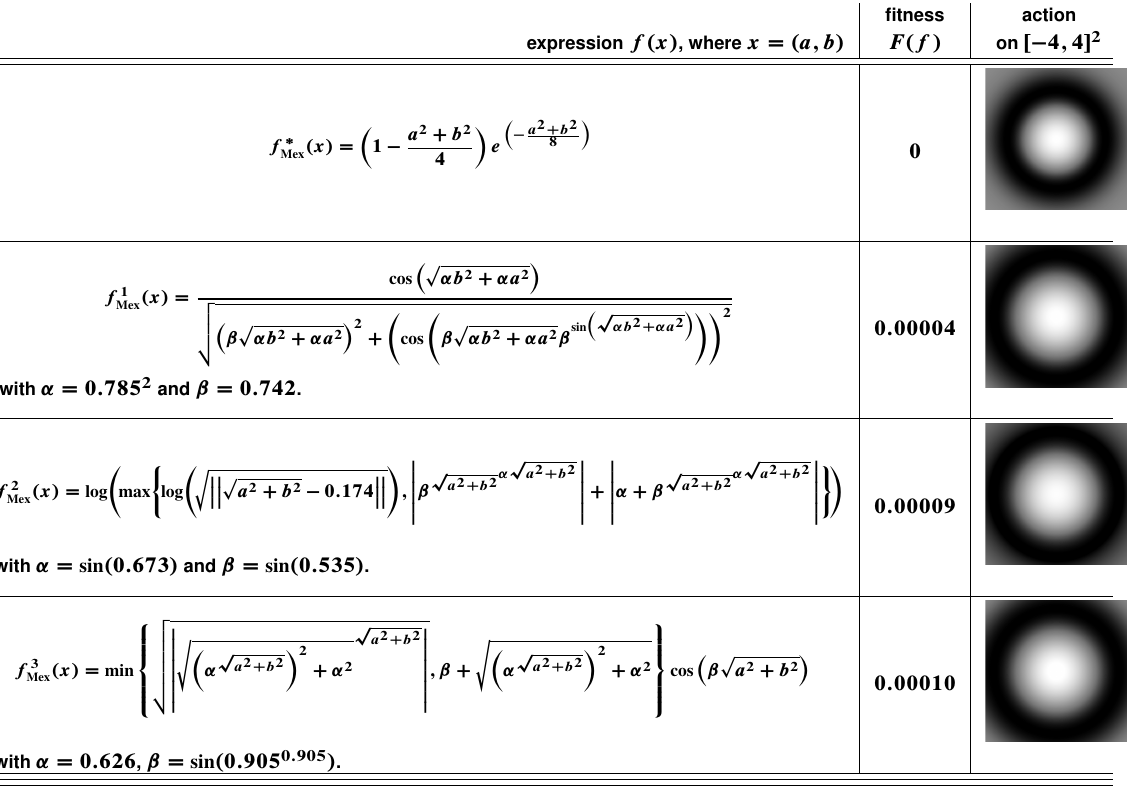
fitness action expression f.x/ , where x D .a;b/ F.f / on Œ (cid:0) 4;4(cid:141) 2